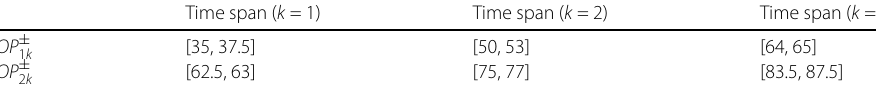
Table 2 Facility running cost (in